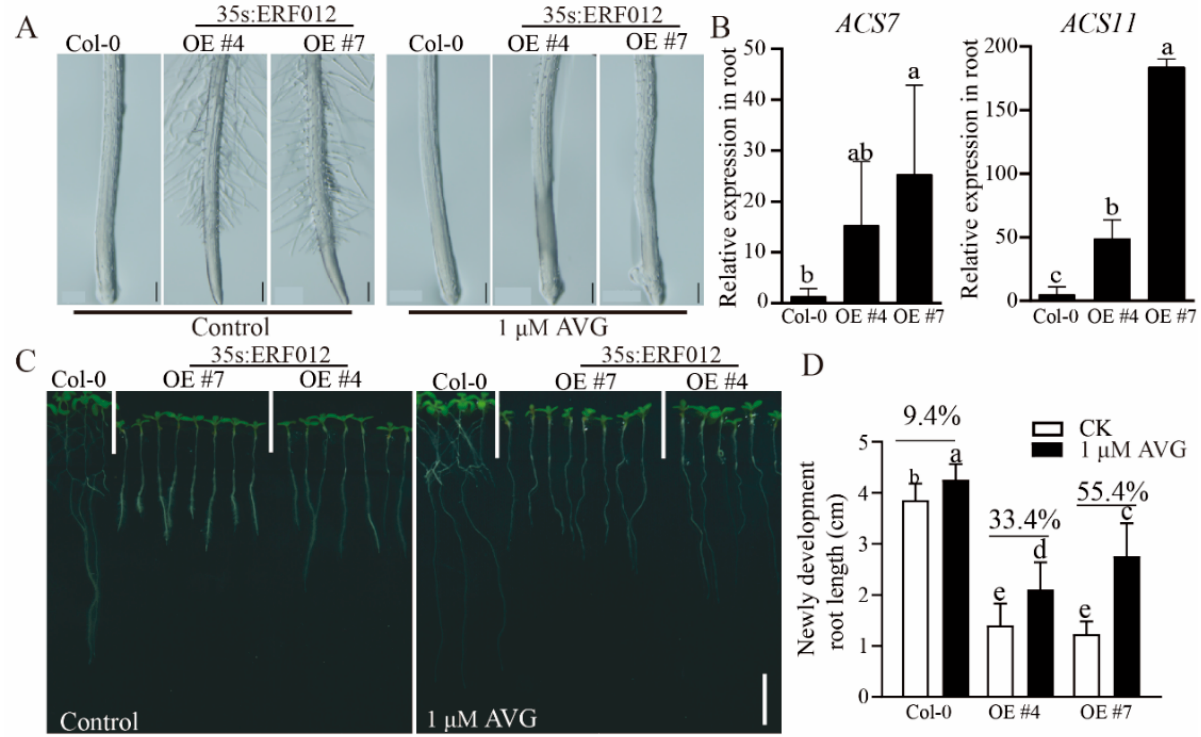
Figure 5. ERF012 activates ethylene biosynthesis in the root and regulates root tip growth. ( A ) Ethylene biosynthetic inhibitor AVG (1 μ M) treatment downregulated root hair density in ERF012 -OE lines. Scale bar = 100 μ m. ( B ) Expression levels of ethylene precursors and biosynthetic genes ACS7 and ACS11 in Col-0 and ERF012 -OE lines. Values represent means ± SD, n = 3 pools, with about 20 plant roots per pool. ( C ) Ethylene biosynthetic inhibitor AVG (1 μ M) treatment re- stored root growth in ERF012 -OE lines. Five-day-old seedlings were transferred to the medium supplemented with or without IAA for 6 days of growth. Scale bar = 1 mm. ( D ) Statistical calcula- tion of the newly developed root length treated with or without AVG (1 μ M) in figure ( C ). Values represent means ± SD, n = 16. Letters indicate significant differences between different plants: Duncan’s test ( p < 0.05).